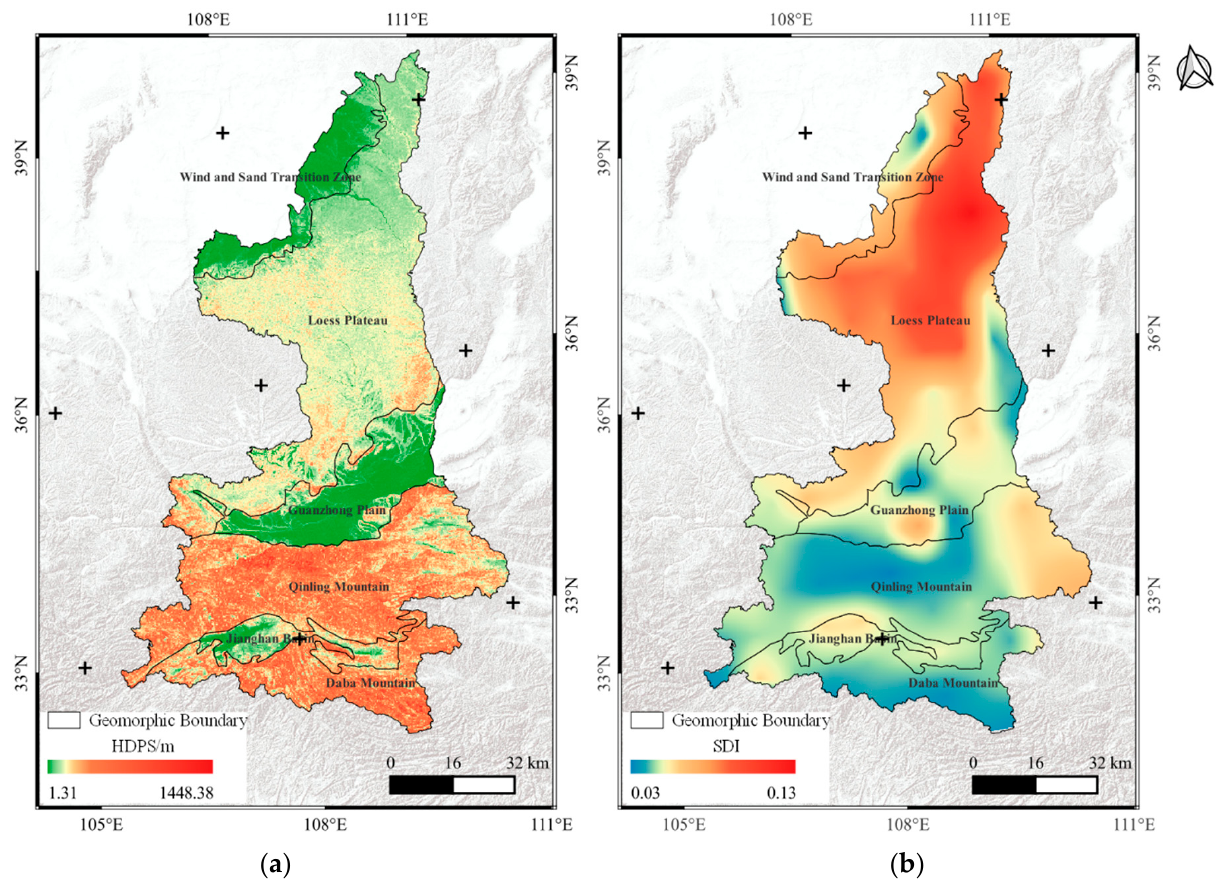
Figure 14. Spatial distribution of the HDPS and SDI: ( a ) spatial distribution of the HDPS in Shaanxi Province; ( b ) spatial distribution of the SDI in Shaanxi Province.